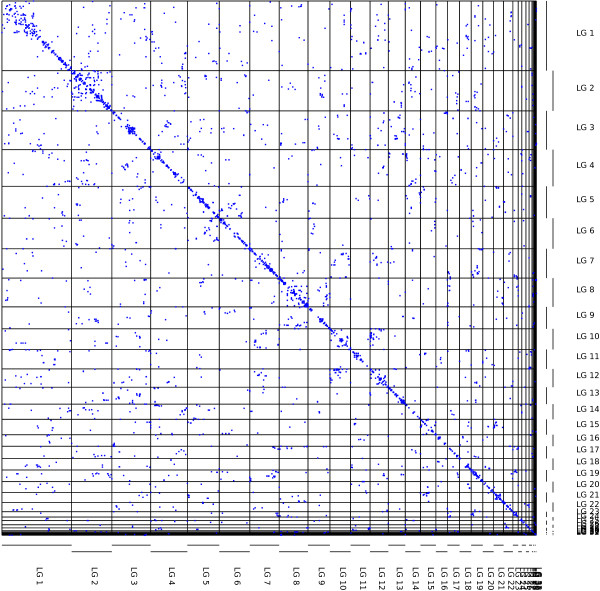
Genomic distribution of candidate paralogs. The map positions of pairs of putatively paralogous protein coding genes within the L. polyphemus genome are plotted with blue points. Pairs are biased toward nearby map positions, and therefore concentrated along the diagonal. Also, paralogs split between linkage groups are significantly clustered into “paralogons”.